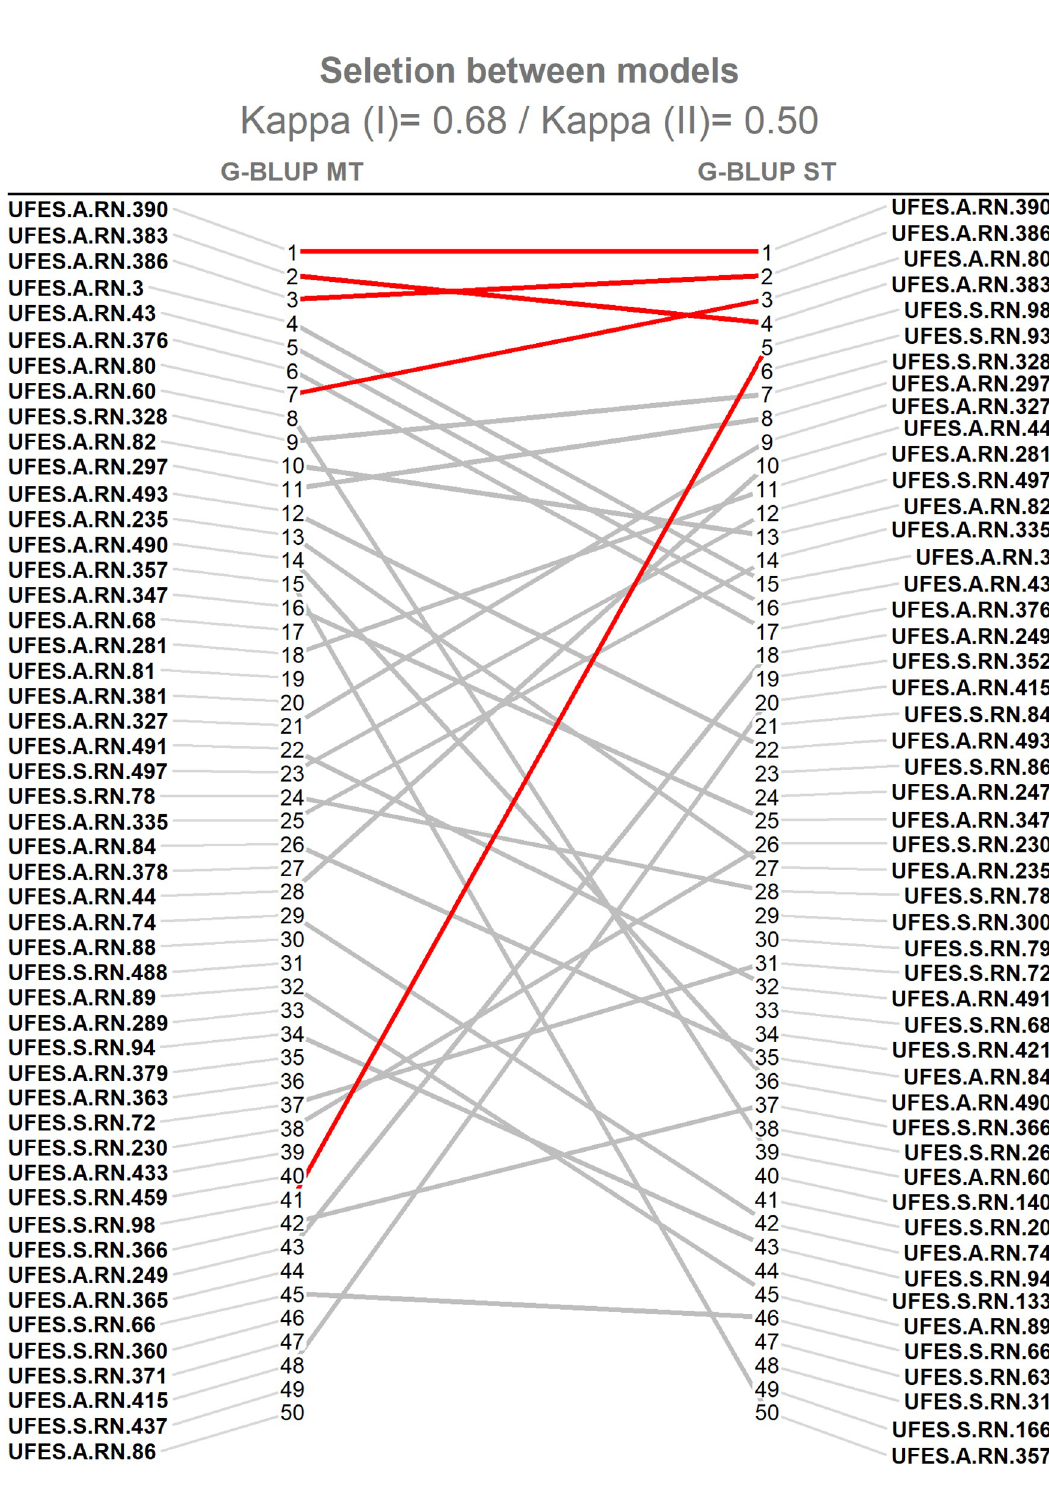
PLOS ONE | https://doi.org/10.1371/journal.pone.0275407 April 7,